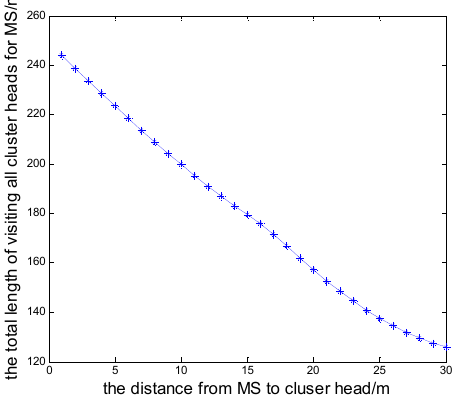
Figure 9. The relationship of the movement distance and stop sites of the MS. Figure 9 . The relationship of the movement distance and stop sites of the MS. Figure 9 . The relationship of the movement distance and stop sites of the MS.